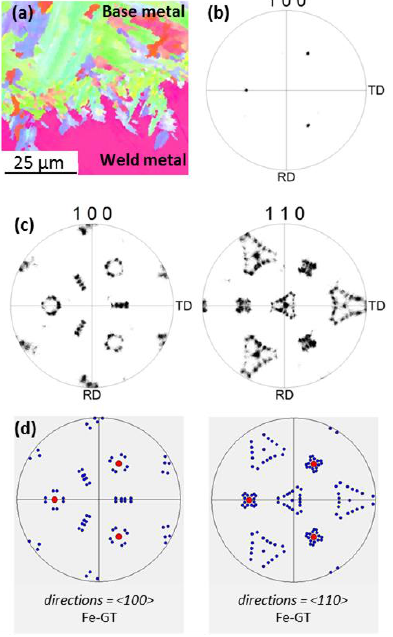
Figure 7. ( a ) EBSD map of some martensitic laths in the base metal and the adjacent austenitic grain in the weld; ( b ) Experimental <100> pole figure from the austenitic grain; ( c ) Experimental <100> and <110> pole figures from the martensitic laths; ( d ) Simulated poles figures, red dots being the <100> directions of the parent austenitic grain and blue dots being the directions of the 24 martensitic variants obtained assuming the GT orientation relationship.